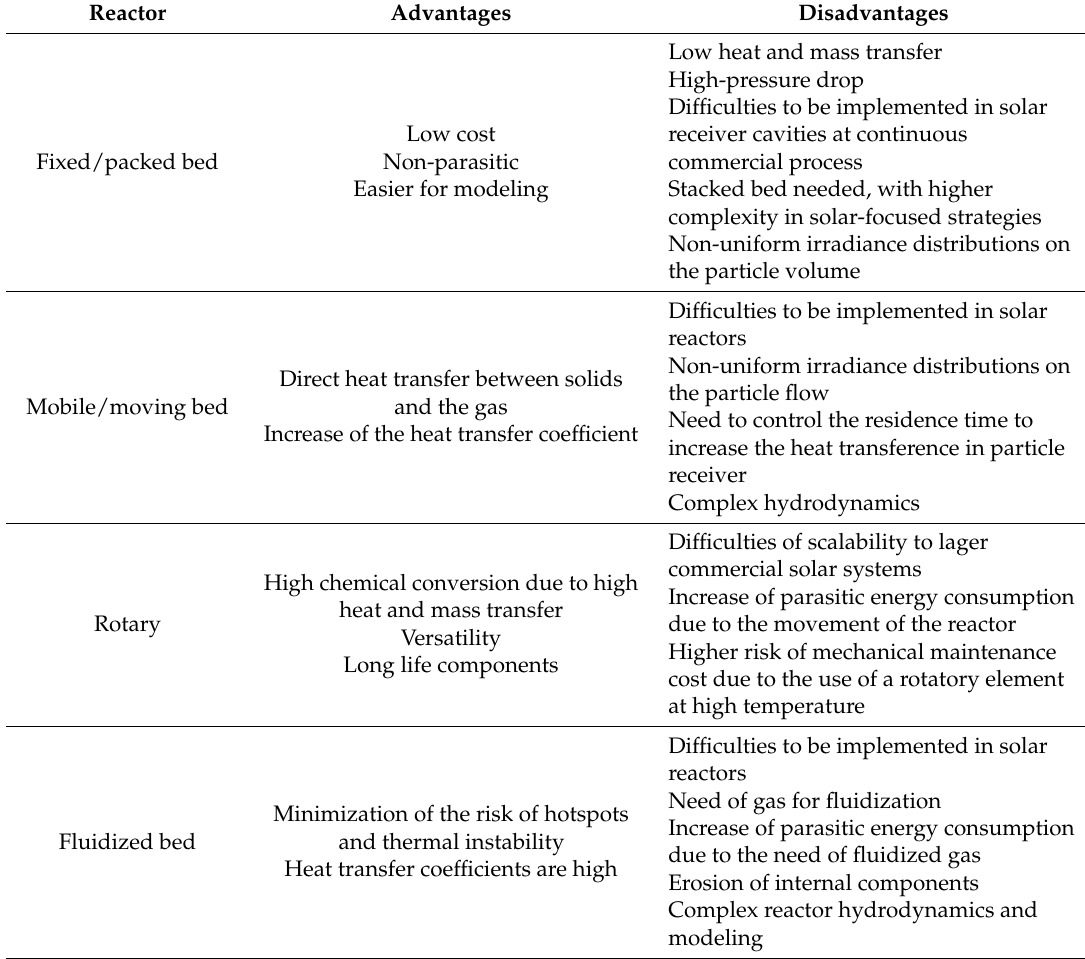
Table 1. Comparison between fixed, moving, and fluidized bed reactors for solar applications [41].